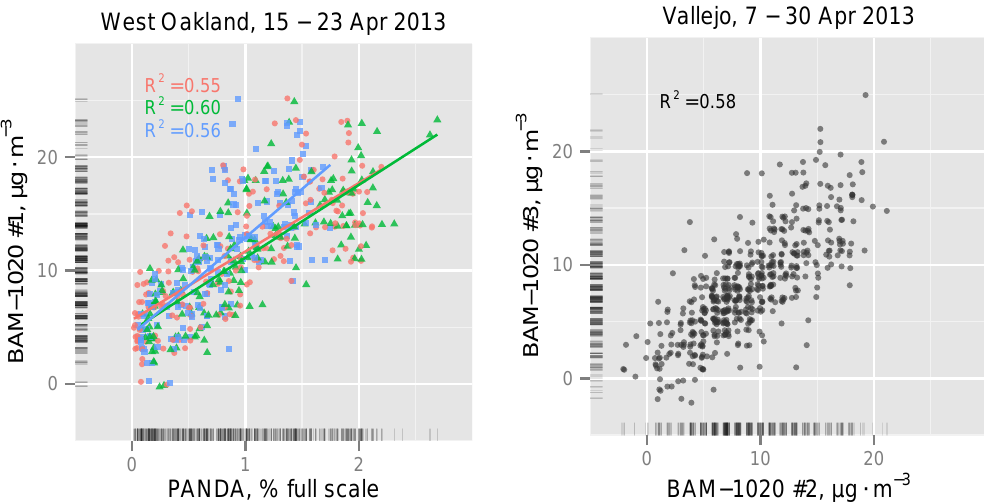
Fig. 3. Left panel: 1h data collected between 15 and 23 April 2013 from three PANDAs and a reference ( β -attenuation) PM 2 . 5 instrument at the regulatory monitoring site in Oakland. Right: approximately the same level of agreement ( R 2 ≈ 0.6) was found between 1h data from a pair of β -attenuation instruments at a nearby regulatory monitoring site in Vallejo, California (40km away), 7–30 April 2013. The original 1h BAM data were available only at 1µgm − 3 resolution; points are jittered to reduce overplotting. Superimposed lines represent linear regressions of unjittered 1h data.